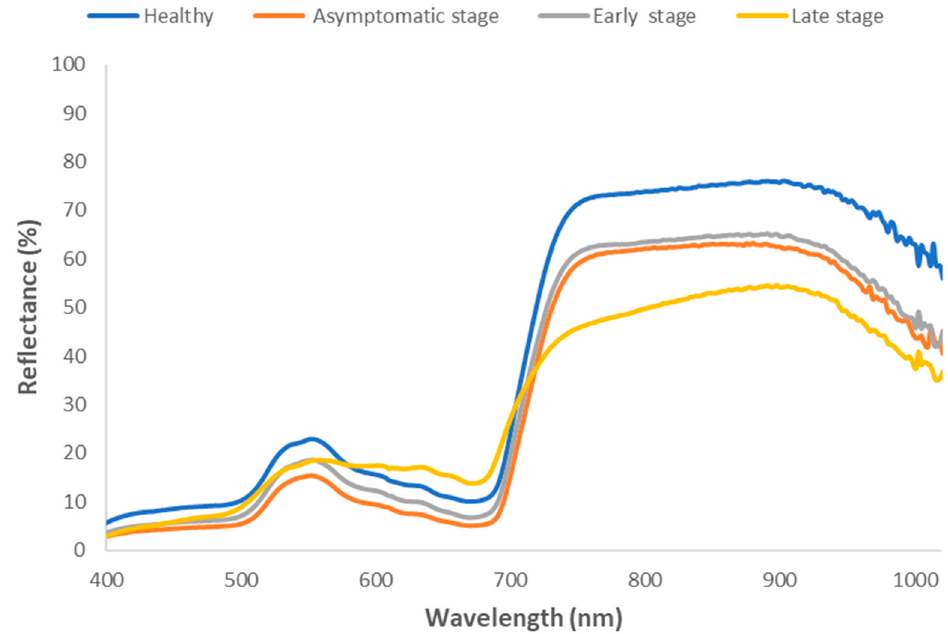
Figure 5. The spectral signatures of the four categories—healthy, asymptomatic, early, and late disease development stages—for leaves in laboratory conditions. Spectral reflectance signatures produced by the indoor leaf analysis are shown with different colored lines.